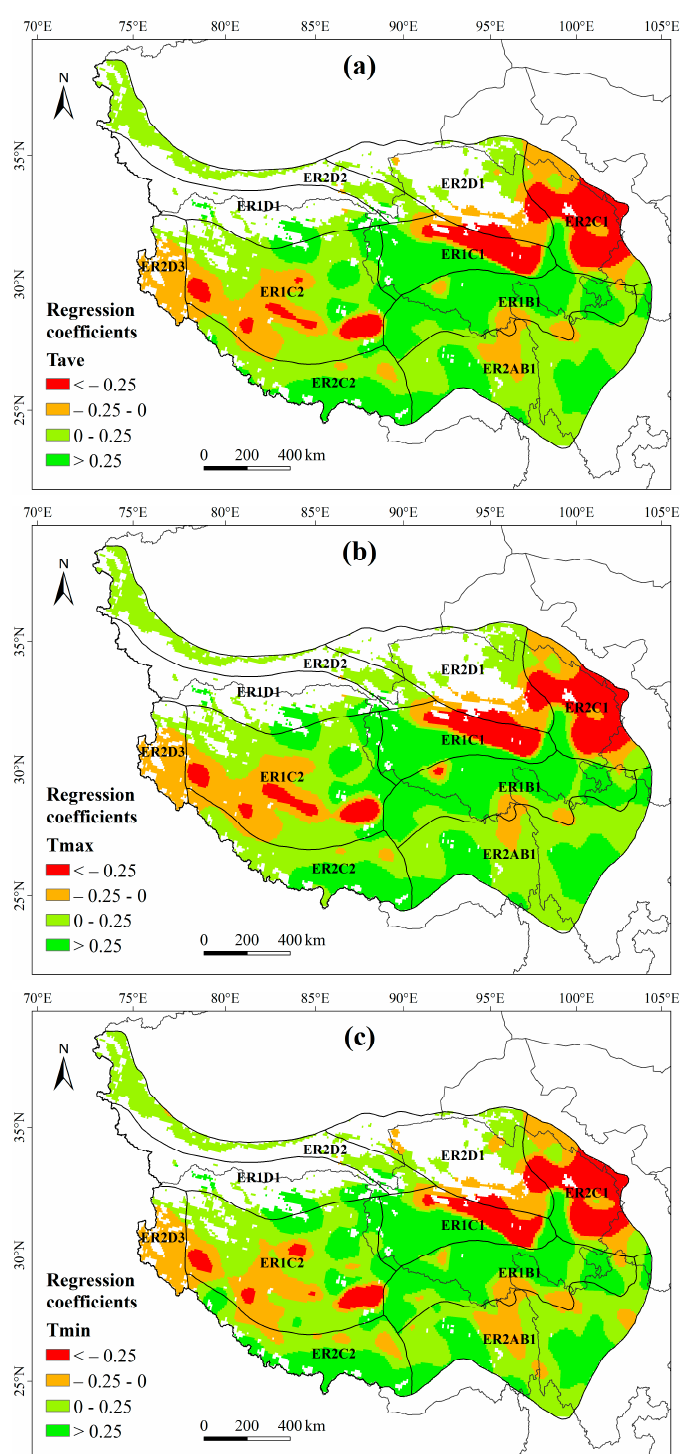
Figure 3. The spatial pattern regression coefficients for temperature ( a ): T ave ; ( b ): T max ; ( c ): T min , in the geographically weighted regression